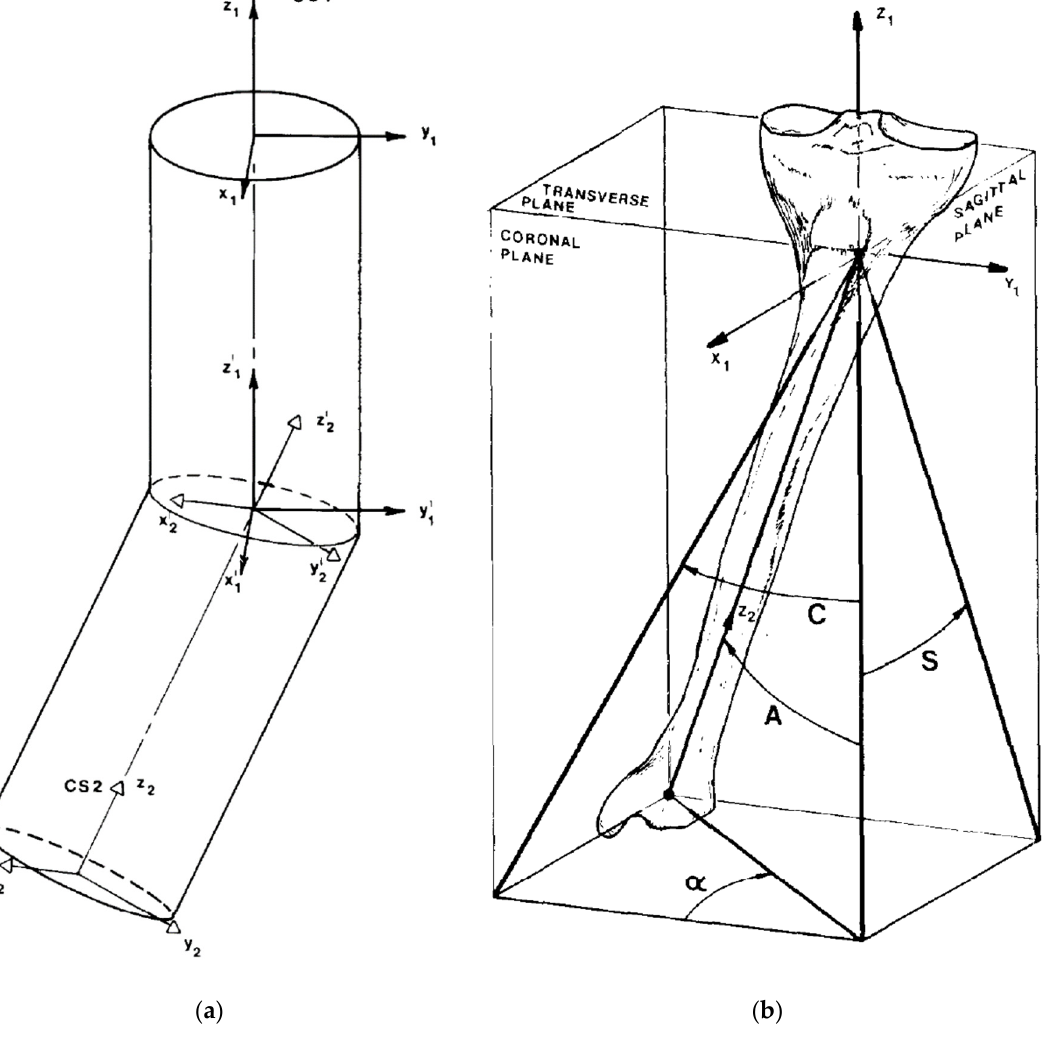
Figure 1. ( a ) The mathematical model describes the deformed bone as two cylinders of equal radii whose axes intersect at the level of deformity to define an elliptical plane. These cylinders are “bent” and rotated relative to each other in space. ( b ) Tibial model with proximal metaphyseal deformity demonstrating projections of the true deformity in the coronal and sagittal views. Angle A is the angulation of the true deformity measured on the maximum deformity view. Angle α , i.e., the orientation angle, is the difference between the coronal plane view and the maximum deformity view